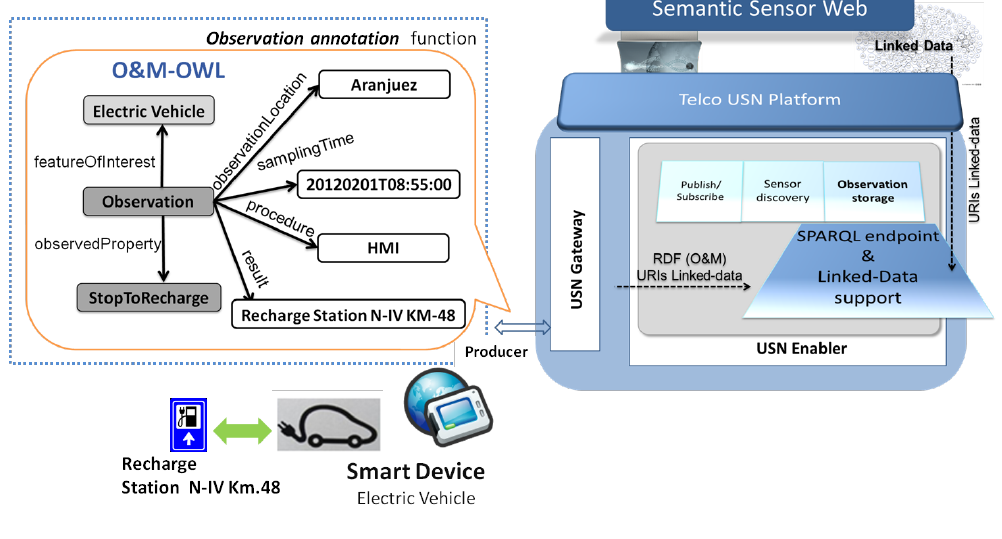
Figure 4. Adding semantic features to the Smart Device and Telco